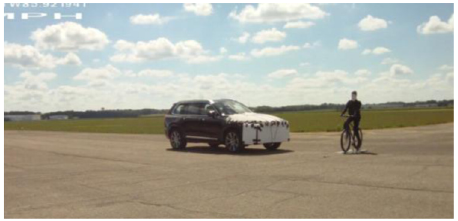
Figure 24 Crossing the road with constant speed testing